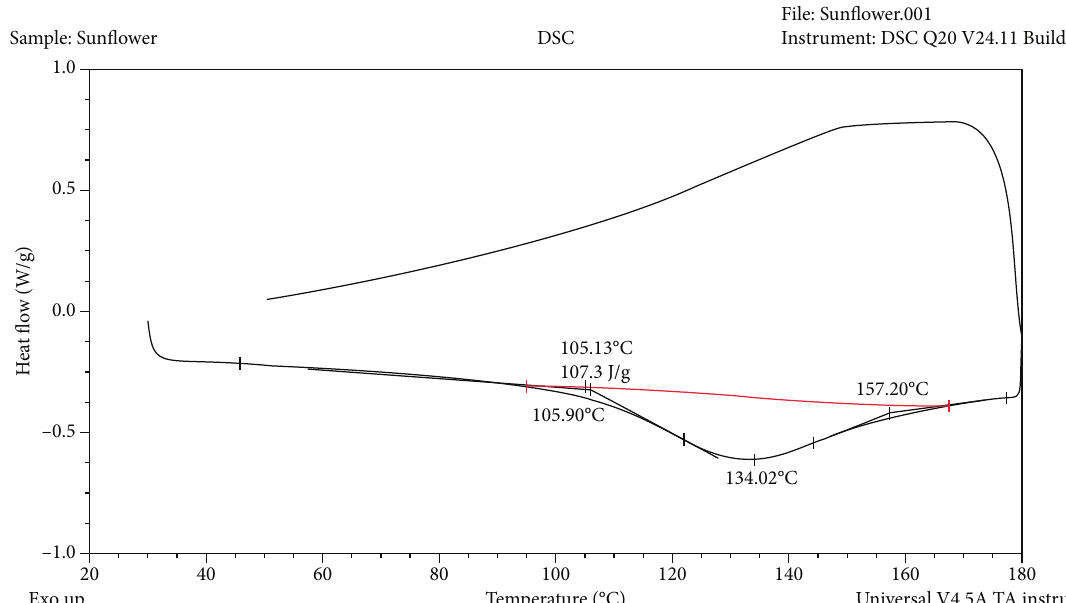
Figure 3: Di ff erential scanning calorimetry of deproteinized ethanol-treated sun fl ower